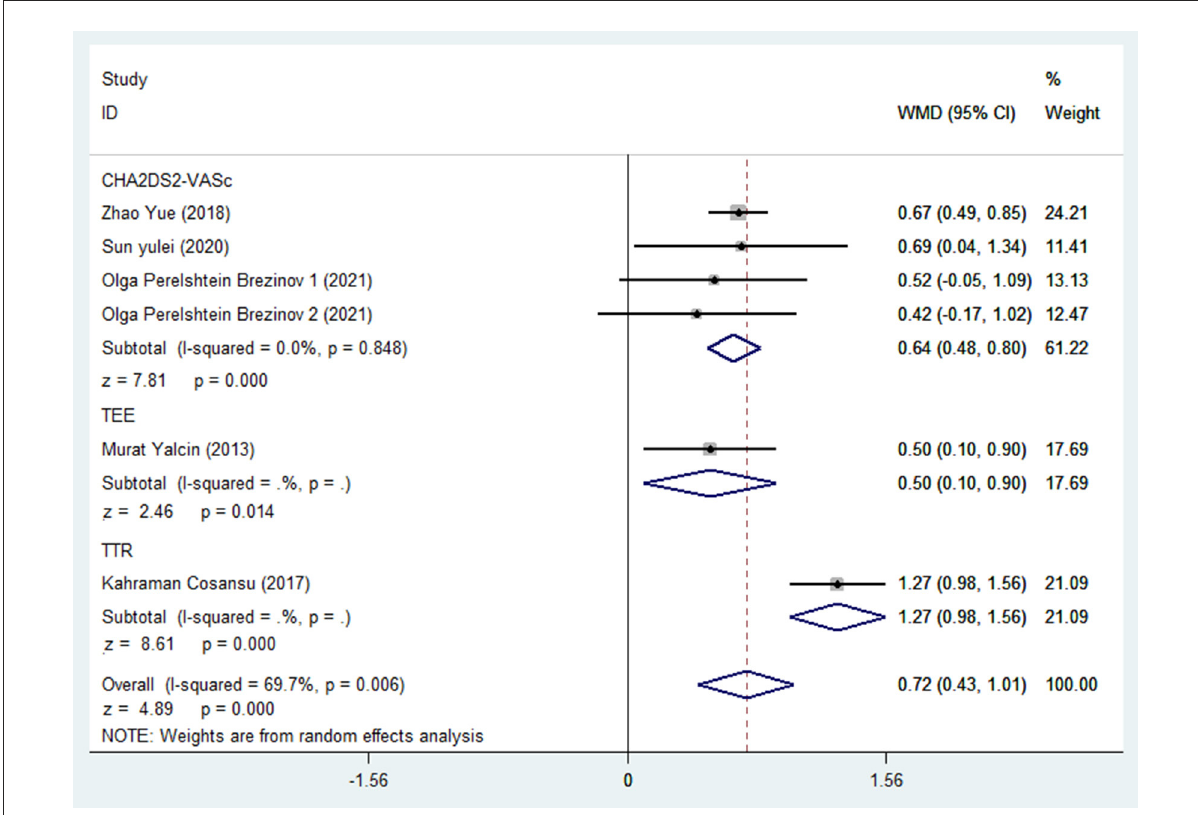
FIGURE2 Forest plot of WMD for association between different stroke risks and NLR levels in patients with